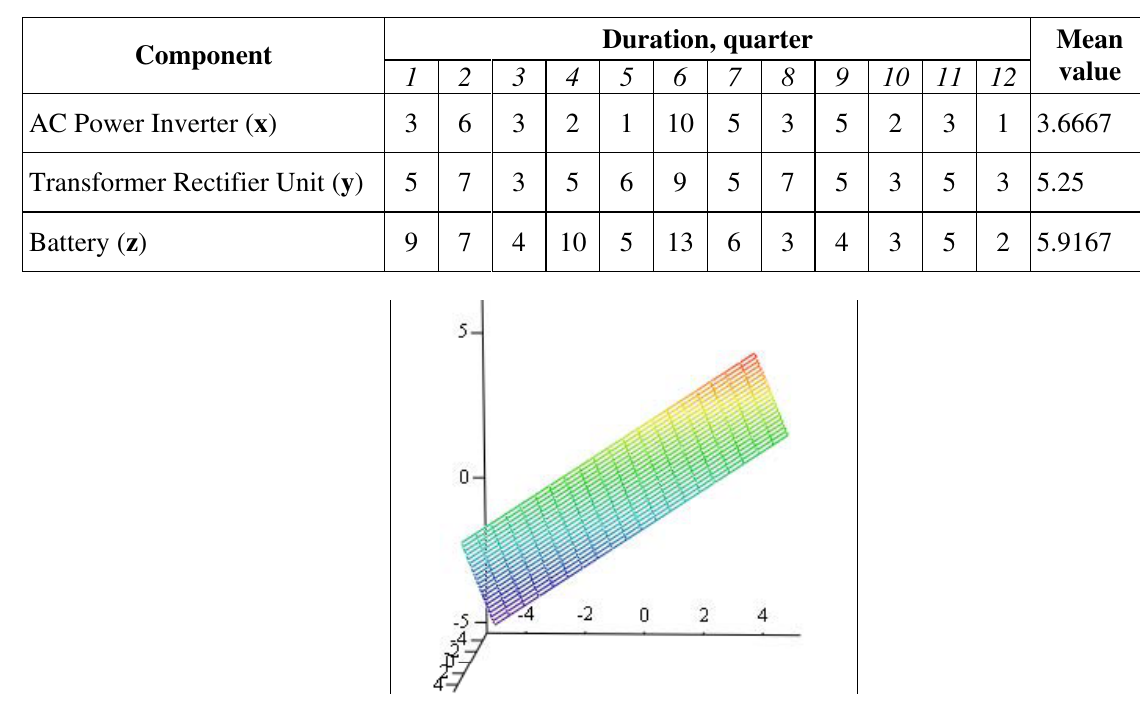
Fig 5. Regression plane of AC Power Inverter (X), Transformer Rectifier Unit (Y), and Battery